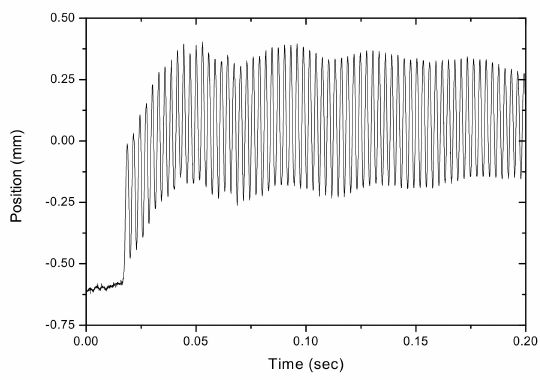
Figure 8. Vibration signal for the non-moving string, detected with the PSD.